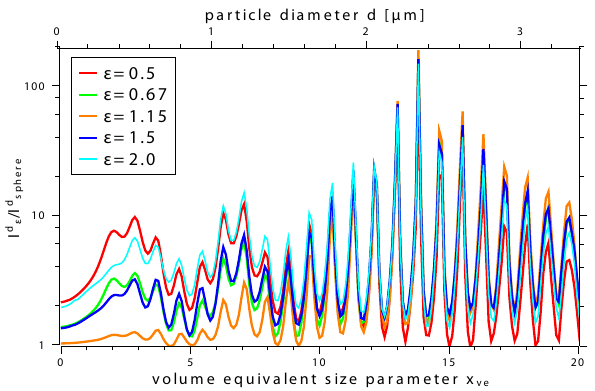
Fig. 3. Intensity on detector area (PMT C) I d ented spheroids normalized by I d size parameter x ve for different aspect ratios (cid:15) .